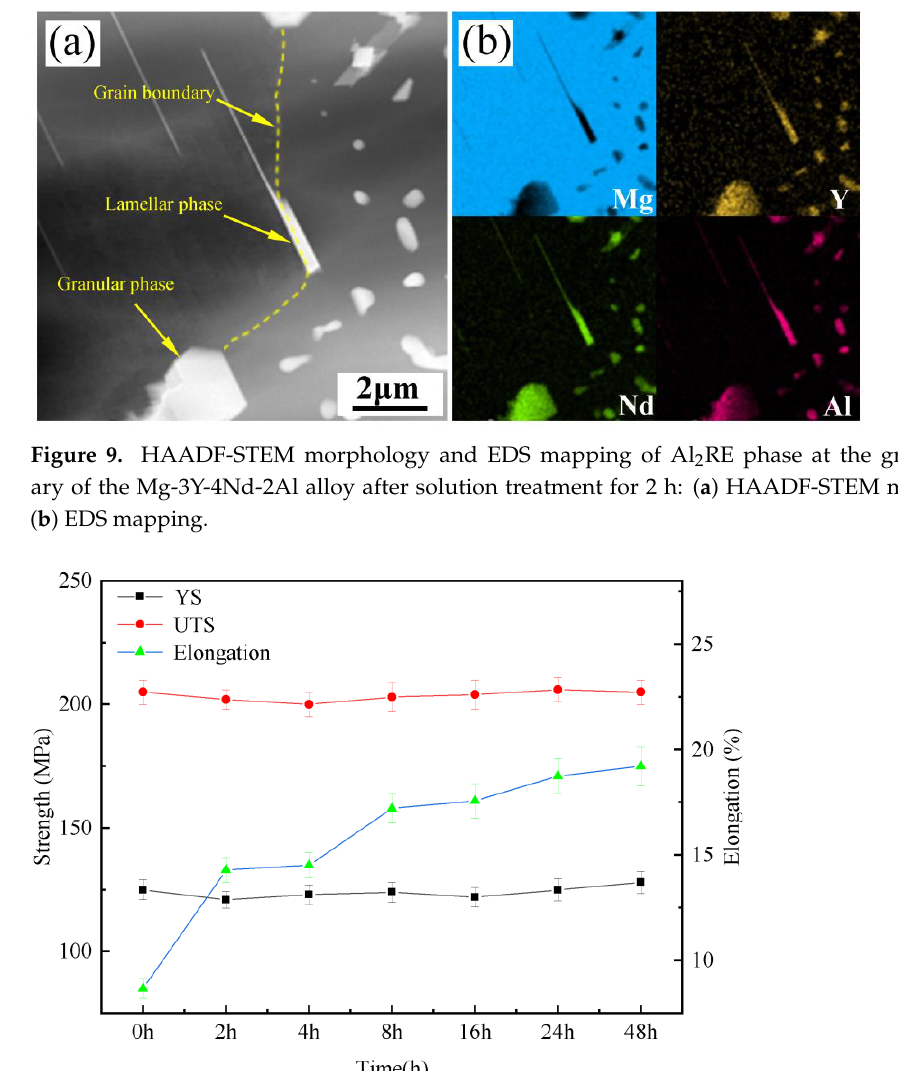
Figure 10. Tensile properties of the Mg-3Y-4Nd-2Al alloy after solution treatment at 545 °C for dif- ferent time periods. different time